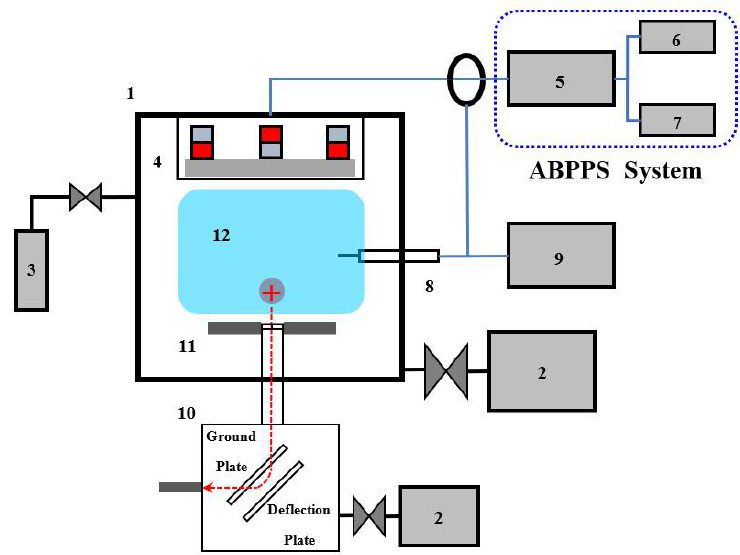
Figure 1. Schematic of the experimental device: (1) vacuum chamber; (2) vacuum pumps; (3) gas delivery system; (4) magnetron sputter; (5) modulator; (6) positive DC P/S; (7) negative DC P/S; (8) Langmuir probe; (9) oscilloscope; (10) ion energy analyzer (a pair of deflecting plates and a particle detector); (11) sample stage; (12) plasma.